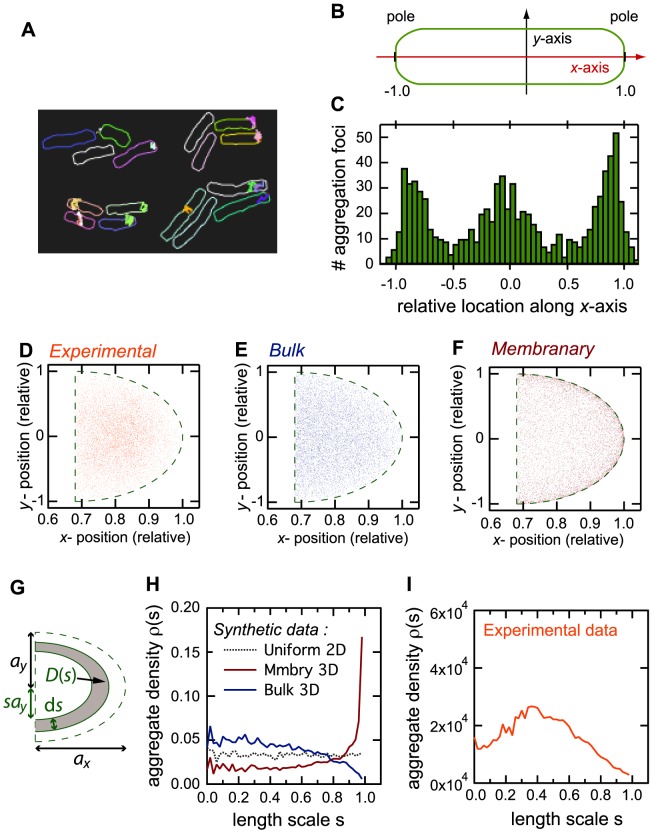
Localization of the detected aggregates in the cells.(A) In each image on the time-lapse fluorescence movies, the bacterial cells are automatically isolated (each individual cell is given a unique random color). The aggregates appearing during the movie are automatically detected and their trajectory within the cell quantified (internal trajectories). (B) By convention, we referred to the projection of the aggregate location on the long axis of the cell as the x-component and that along the short axis as the y-component. (C) Histogram of the x-component of the initial position of the trajectories (total of 1,644 trajectories). Since the cell length at the start of the trajectory is highly variable, the x-component was rescaled by division by the cell half-length. After this normalization, the cell poles are located at locations −1.0 and 1.0 respectively, for every trajectory. (D) Experimentally measured positions of the aggregates detected in the poles (both poles pooled, n = 9,242 points). The green-dashed curves in (D–F) locate the 2d projection of the 3d semi-ellipsoid that was used to approximate the cell pole. (E) Synthetic data for bulk positions: 10,000 3d positions were drawn uniformly at random in the 3d semi-ellipsoid pole. The figure shows the corresponding 2d projections. (F) Synthetic data of membranary positions: 10,000 3d positions were drawn uniformly at random in the external boundary (membrane) of the 3d semi-ellipsoid pole. The figure shows the corresponding 2d projections. (G) To quantify figures D–F, the correlation function ρ(s) was computed as the density of positions located within crescent D(s) (gray). See text for more detail. (H–I) Local density of aggregate positions ρ(s) in the synthetic (H) and experimental (I) data shown in E (bulk, blue), F (membranary, red) and D (experimental, orange). The dashed black line shows the local density computed for 10,000 synthetic 2d positions that were drawn uniformly at random in the 2d semi-ellipse resulting from the 2d projection of the 3d pole ellipsoid (green dashed curve in D–F).